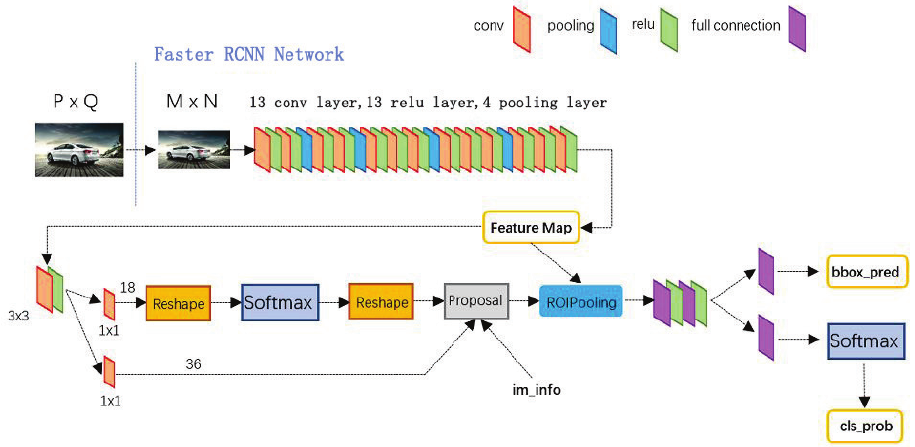
Figure 1. Faster R-CNN network structure